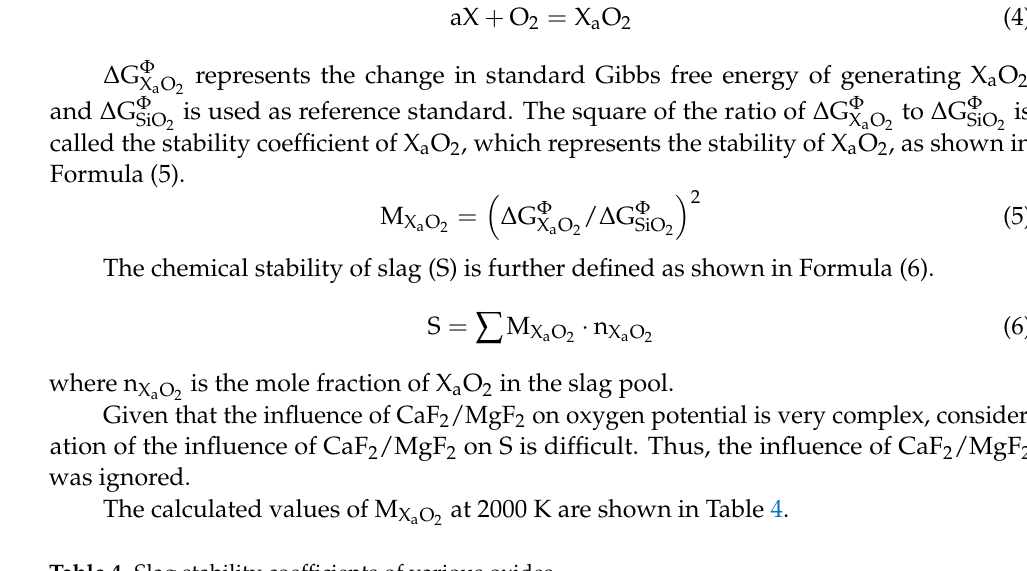
Table 4. Slag stability coefficients of various oxides.